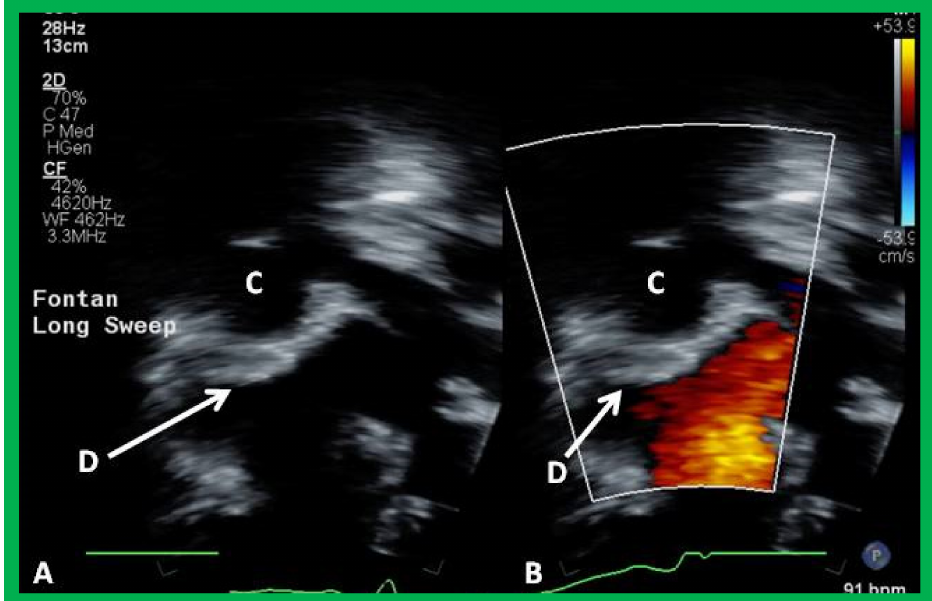
Figure 19. Echo images from apical four chamber projection illustrating the location of the Amplatzer device (D), indicated by arrows in ( A , B ). Note that there is no residual shunt demonstrated as shown in B. Conduit (C) is labeled. Reproduced from Reference